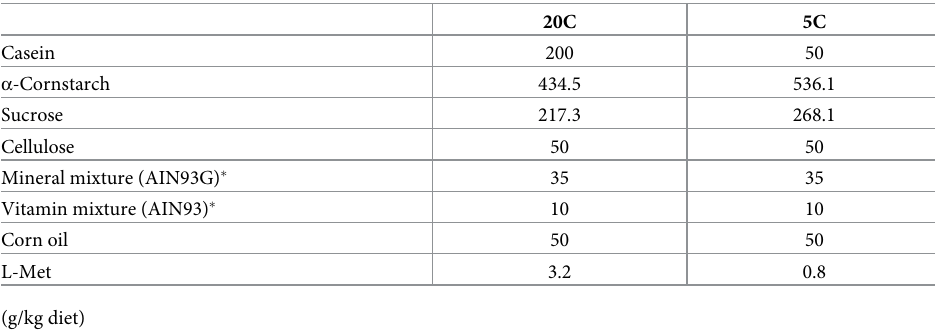
Table 1. Composition of the experimental